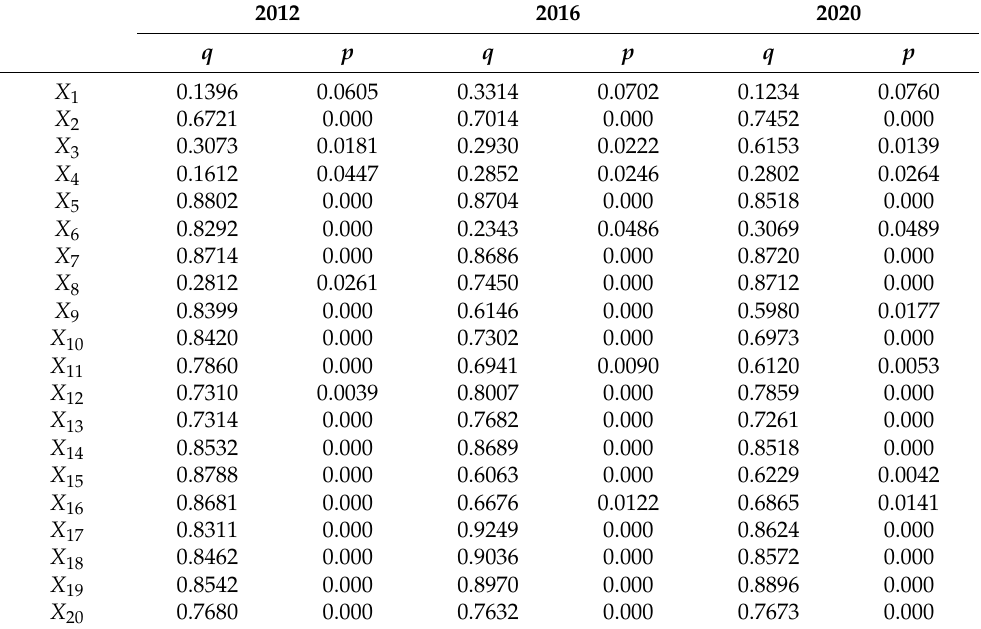
Table 3. Analysis of influencing factors of urban service-land area.